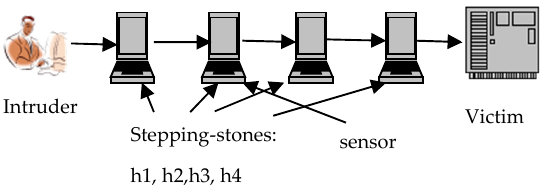
Figure 2. A long connection chain with Intruder, Stepping-stones and Victim.